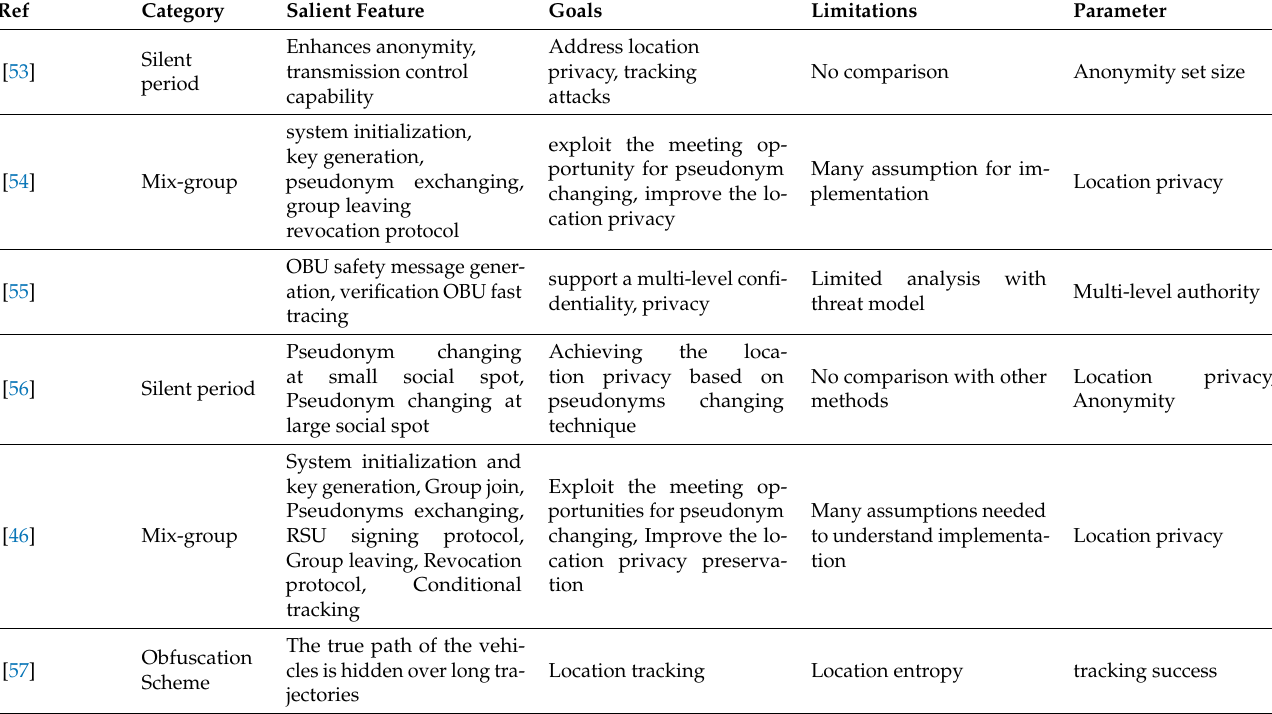
Table 2. VANETs location privacy schemes used in different papers.